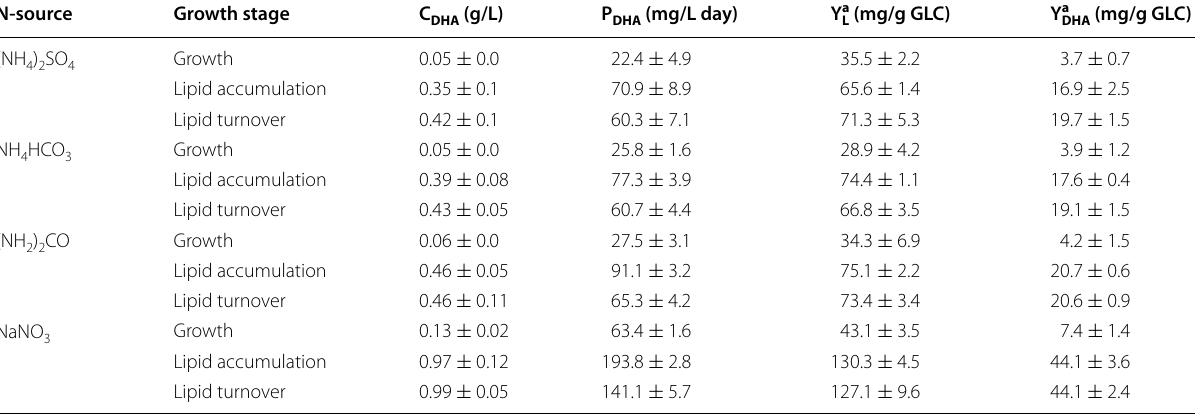
All experiments were performed in triplicate. The data presented here is mean